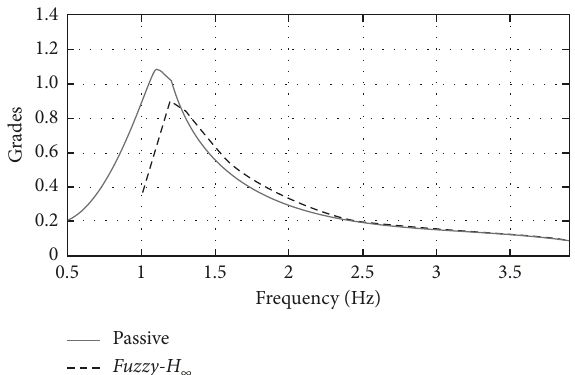
Figure 22: Pitch angle θ (in degrees). The objective is to reduce θ as much as possible.